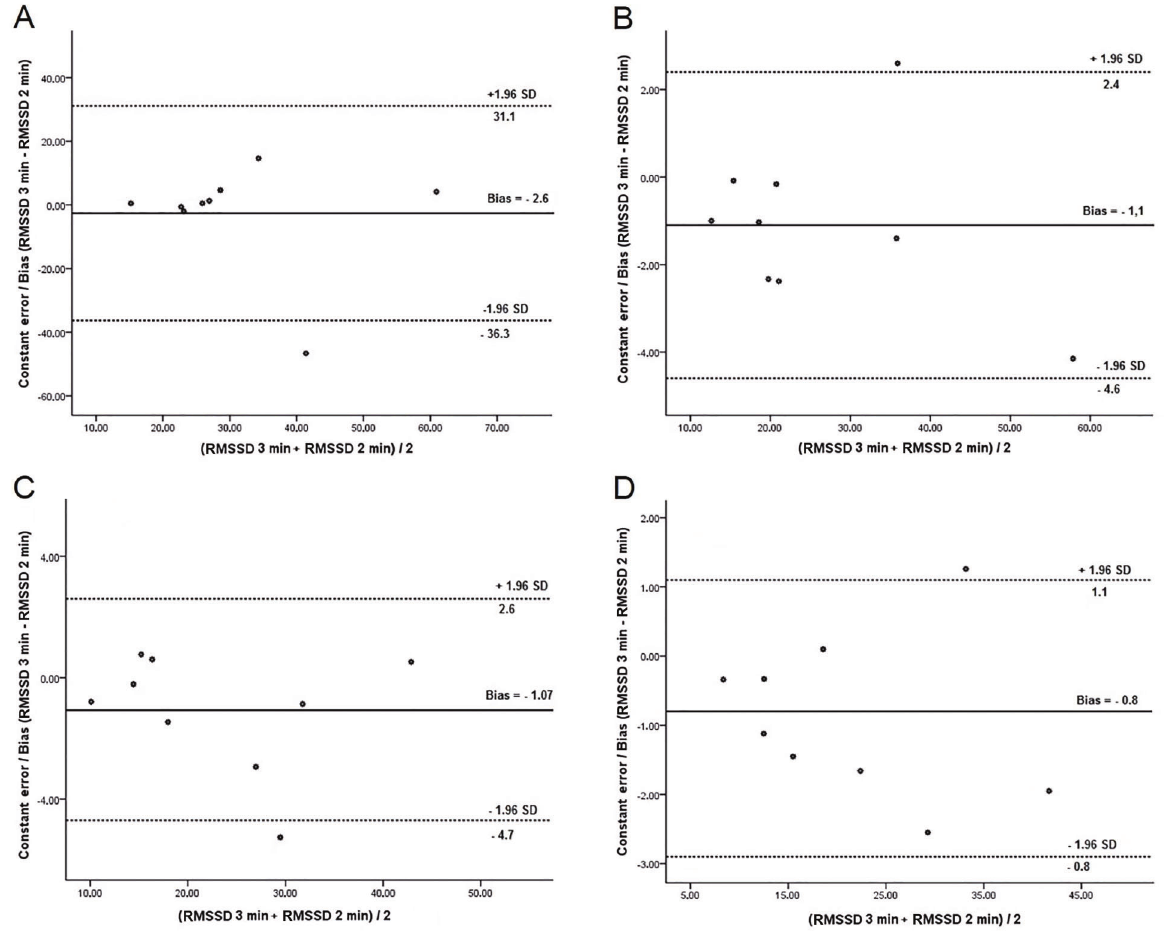
Figure 2. Bland-Altman plots of the differences between RMSSD during 3- and 2-min ignals at different resistance exercise loads. A , B , C , and D represent 10, 20, 30, and 35% 1-RM. The solid middle line indicates bias, while the two dashed lines represent the upper and lower limits of agreement. RMSSD: root mean square of the successive differences. 1-RM: 1-repetition maximum